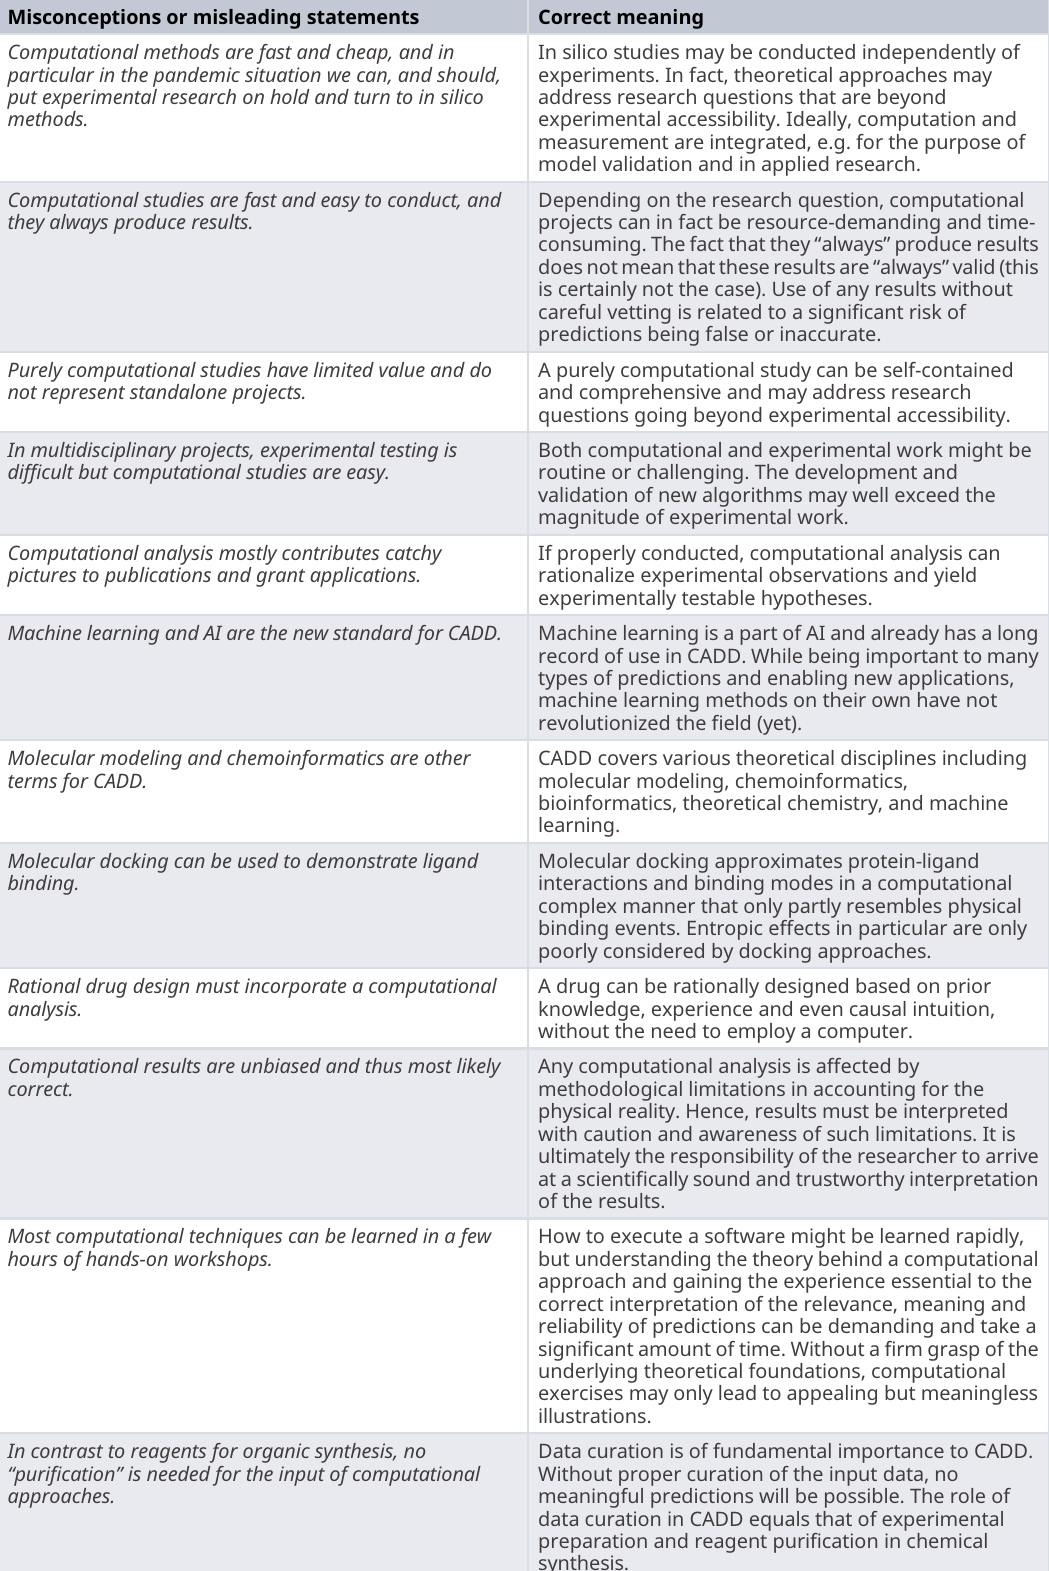
Table 1. Examples of misconceptions versus the intended use accepted by experts in the